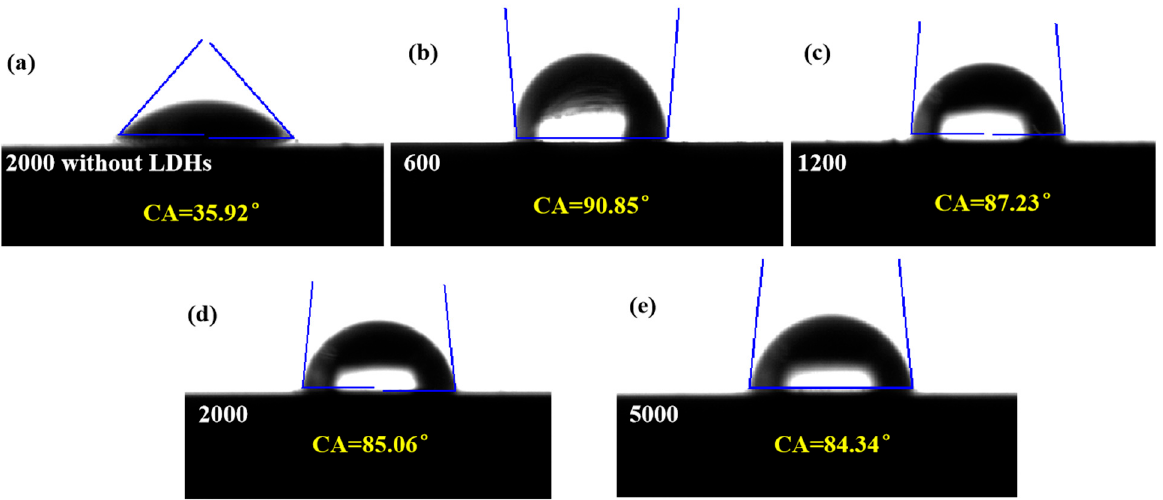
Figure 5. Water contact angle for bare and coated ZnAl-LDHs film samples: ( a ) 2000 (without LDHs); ( b ) 600; ( c ) 1200; ( d ) 2000; ( e ) 5000.